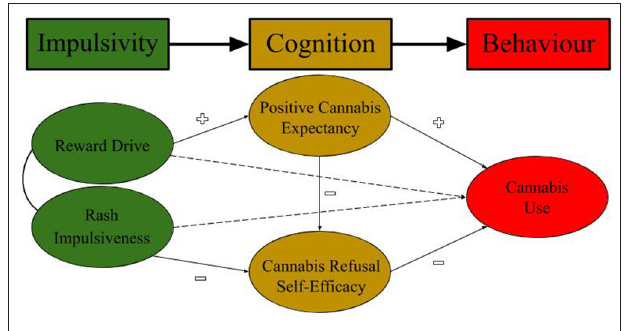
FIGURE 1 | bioSocial Cognitive Theory (bSCT) of Cannabis